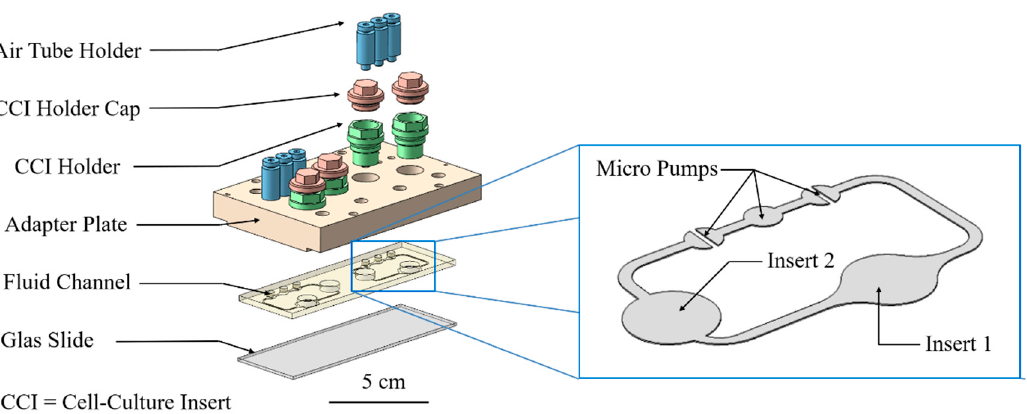
Figure 3. Exploded diagram of the Two-organ chip system. The blue box shows a zoom on the fluid channel with the position of the micro pumps, insert 1 and insert 2.